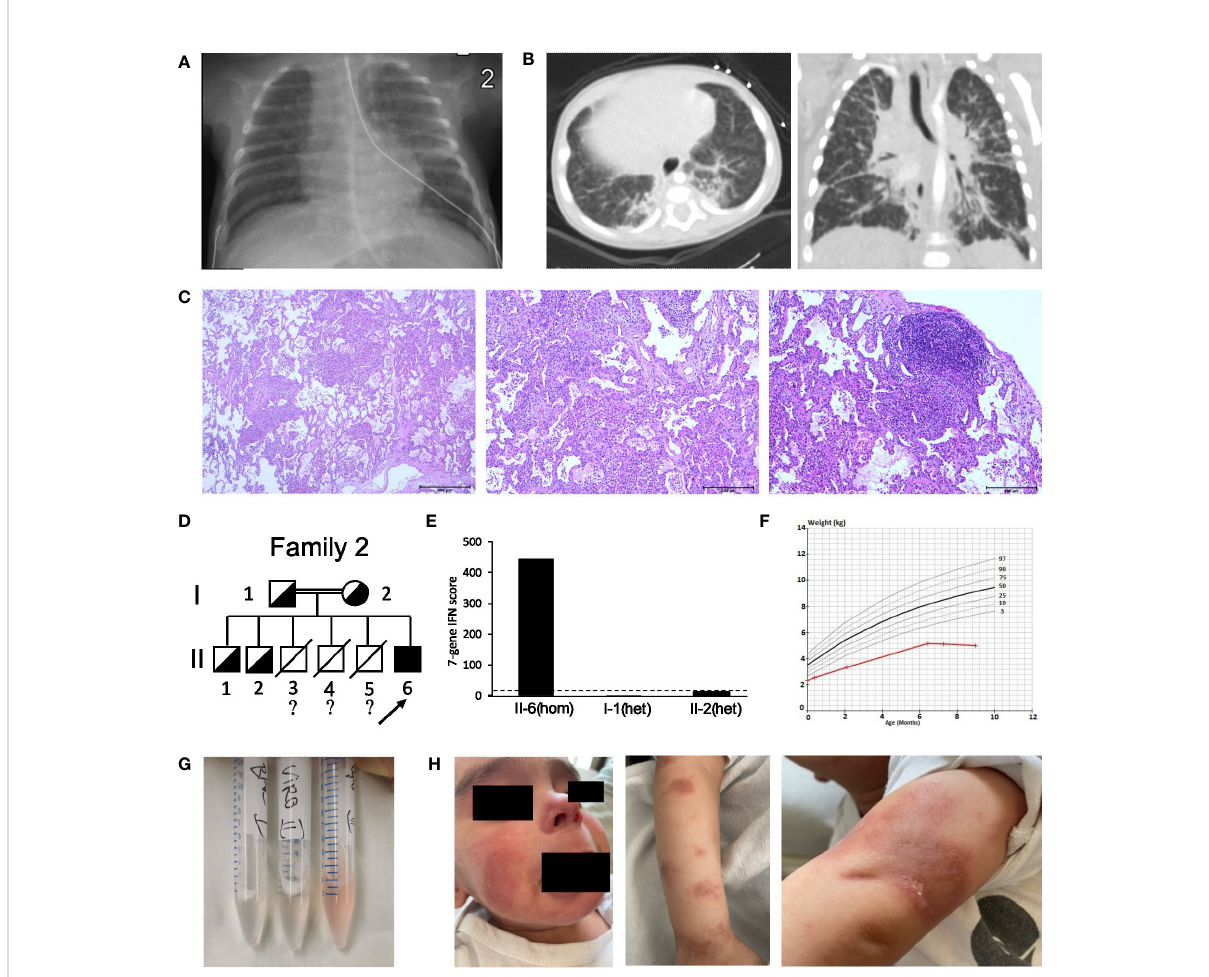
FIGURE 2 Clinical features and pedigree of patient 2. (A) Chest X-ray of the newborn patient, displaying therapy-refractory perihilar streaky consolidations. (B) Low dose chest CT at the age of fi ve month revealed fi brotic changes with traction-bronchiectasis, thickened interlobular and intralobular septa, and architectural distortion. (C) Lung biopsy displaying parenchymal hemorrhage, interstitial glycogenosis, lymphofollicular hyperplasia and accumulation of alveolar macrophages. (D) Pedigree of patient 2 ’ s family; fi lled symbol: homozygosity; half- fi lled symbol, heterozygosity; clear symbol: wild type;?, no information about genotype; slash, died individuals; arrow indicates patient 2 (II-6). (E) IFN score from whole blood for patient 2 with c.841C>T p.(Arg281Trp) homozygosity (hom) and his healthy family members carrying c.841C>T p.(Arg281Trp) in heterozygosity (het); dash line indicates threshold of 12.49 from healthy controls. (F) Weight vs. Age chart for patient 2, displaying failure to thrive. Red line, patient 2; black and grey lines, standard weight-for-age percentiles for 0-12 months breast-fed boys. (G) Sequential bronchoalveolar lavage (BALF) samples indicating alveolar hemorrhage. (H) SAVI characteristic, cutaneous vasculitis of the face and